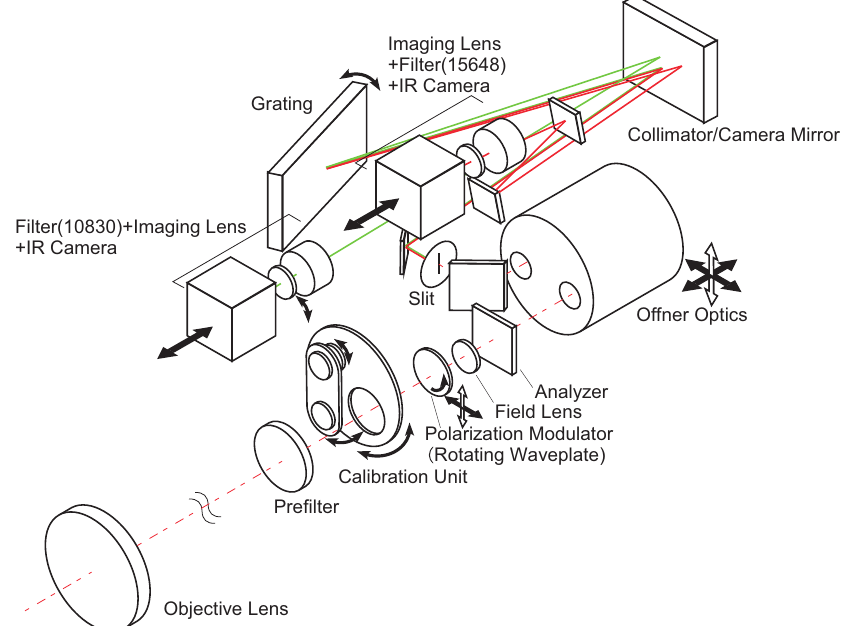
Fig. 4. Schematic diagram of the infrared spectropolarimeter at the rear of T2 (and T3). Red dash-dot lines show the optical axis before the spectrograph slit, while green and red solid lines represent the optical axes of the 1083.0 nm and the 1564.8 nm light in the spectrograph, respectively. The arrows indicate the motion of movable